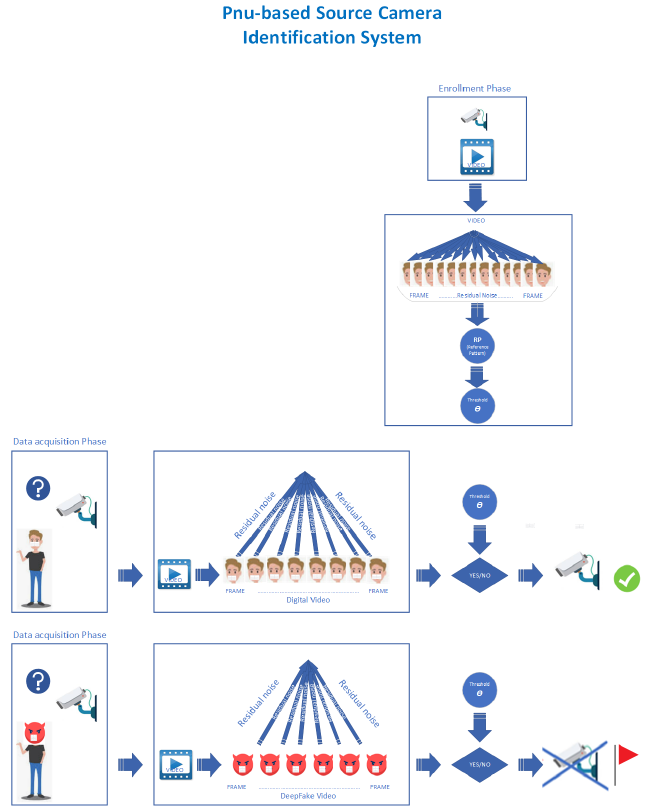
Figure 3. Source Camera Identification Process with a